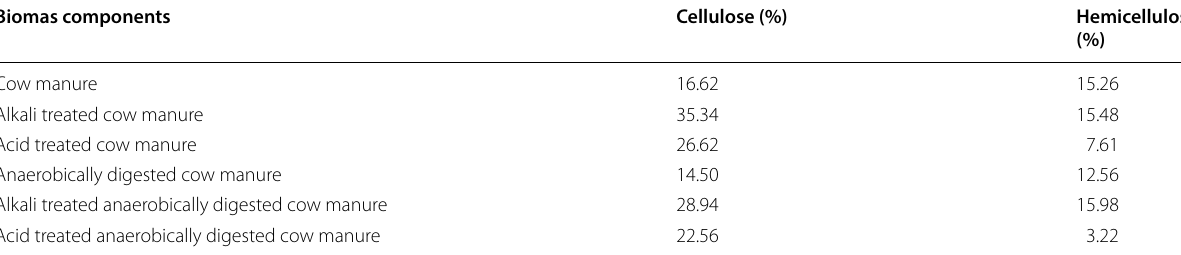
Table 1 Composition of cow manure and anaerobically digested cow manure Biomas components Cellulose (%) Cow manure Alkali treated cow